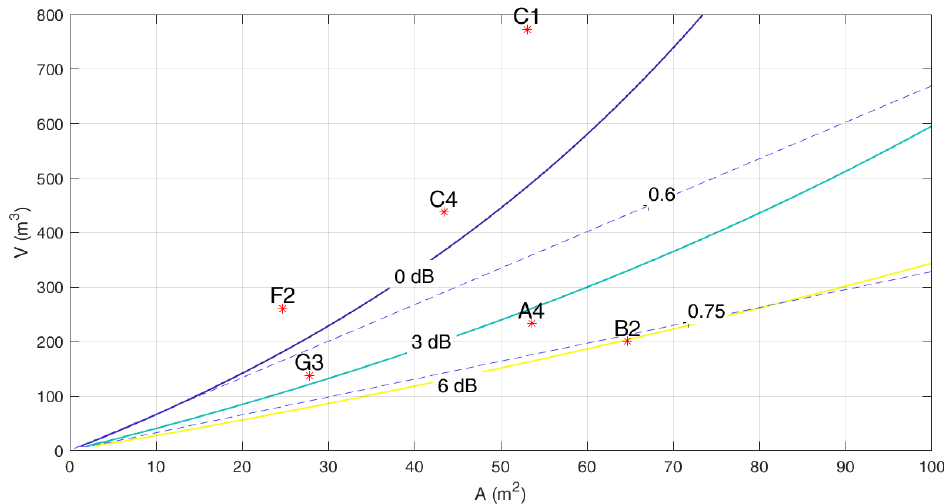
Figure 6. Prediction A – V diagram of speech intelligibility parameters in small-medium classrooms. C 50 contour lines are continuous; STI contour lines are dashed. Classroom values taken from previous work by the authors (C1, C4) [30] and found in the literature (A4, B2, F2, G3) [19] were